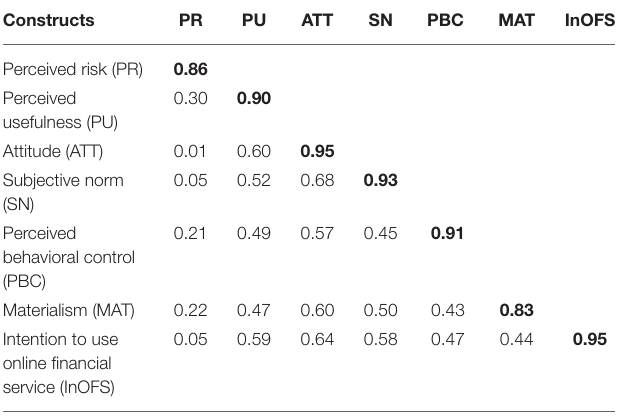
The diagonal elements (bold values) represent the square roots of average variance extracted (AVE) for each construct. Similarly, perceived usefulness positively influences attitude ( β = 0.31, p < 0.001) and perceived behavioral control ( β = 0.31, p < 0.001), respectively. As a result, H5, H8, and H9 are